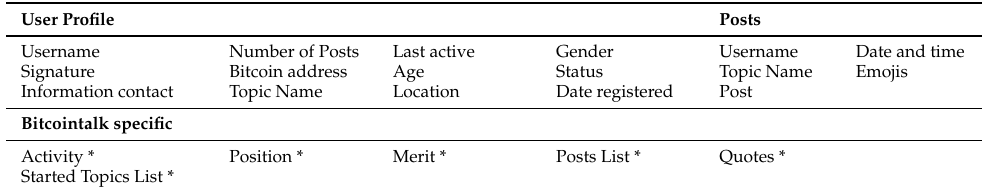
Table 1. Retrieved Information from